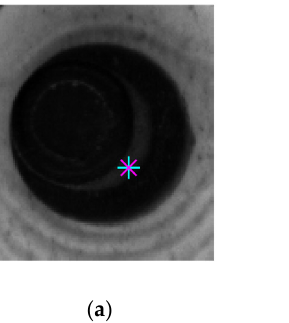
Figure 8. Tracking object segmentation: ( a ) original tracking target; ( b ) segmented circular object.